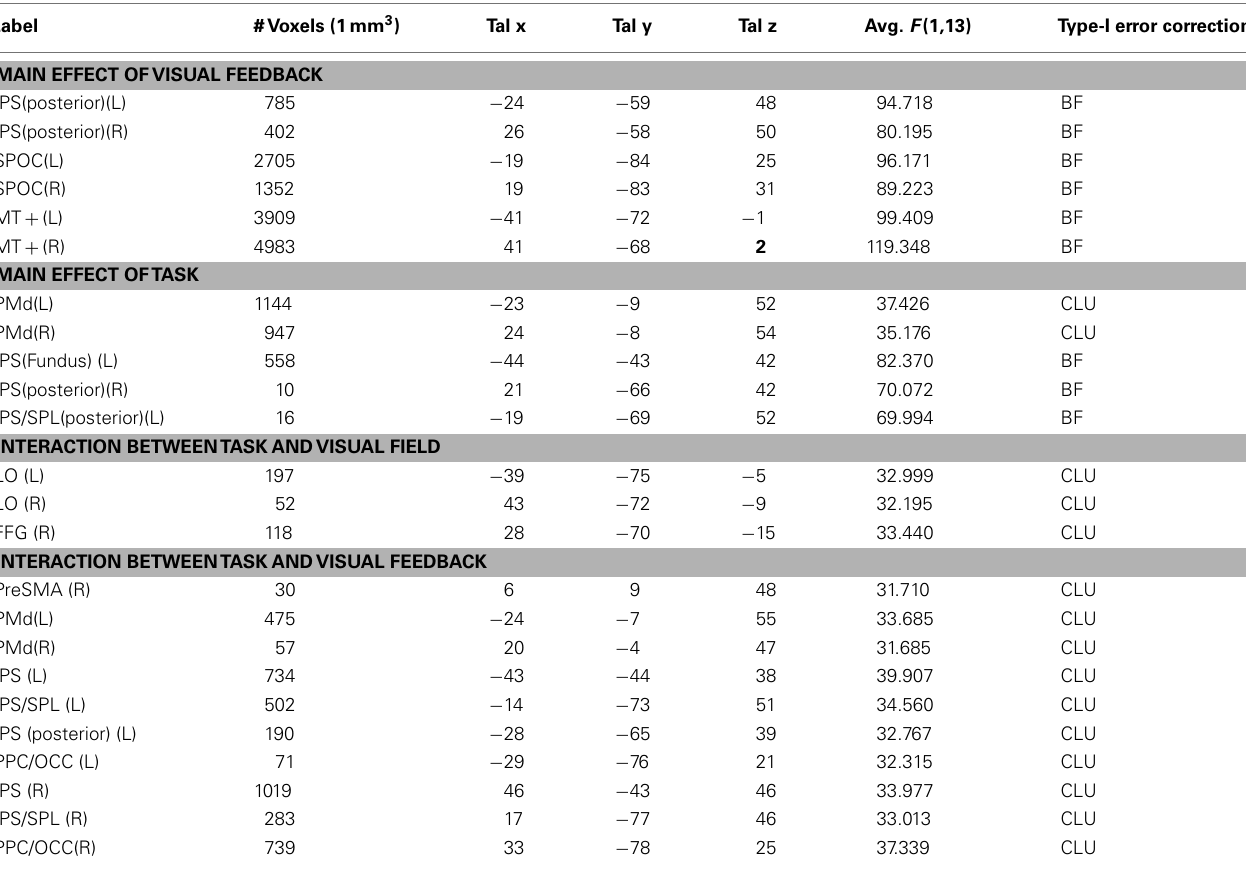
TableA2 | Results of 2 × 2 × 2ANOVA analyses, with “task,” “visual field,” and “visual feedback” as repeated measures factors.